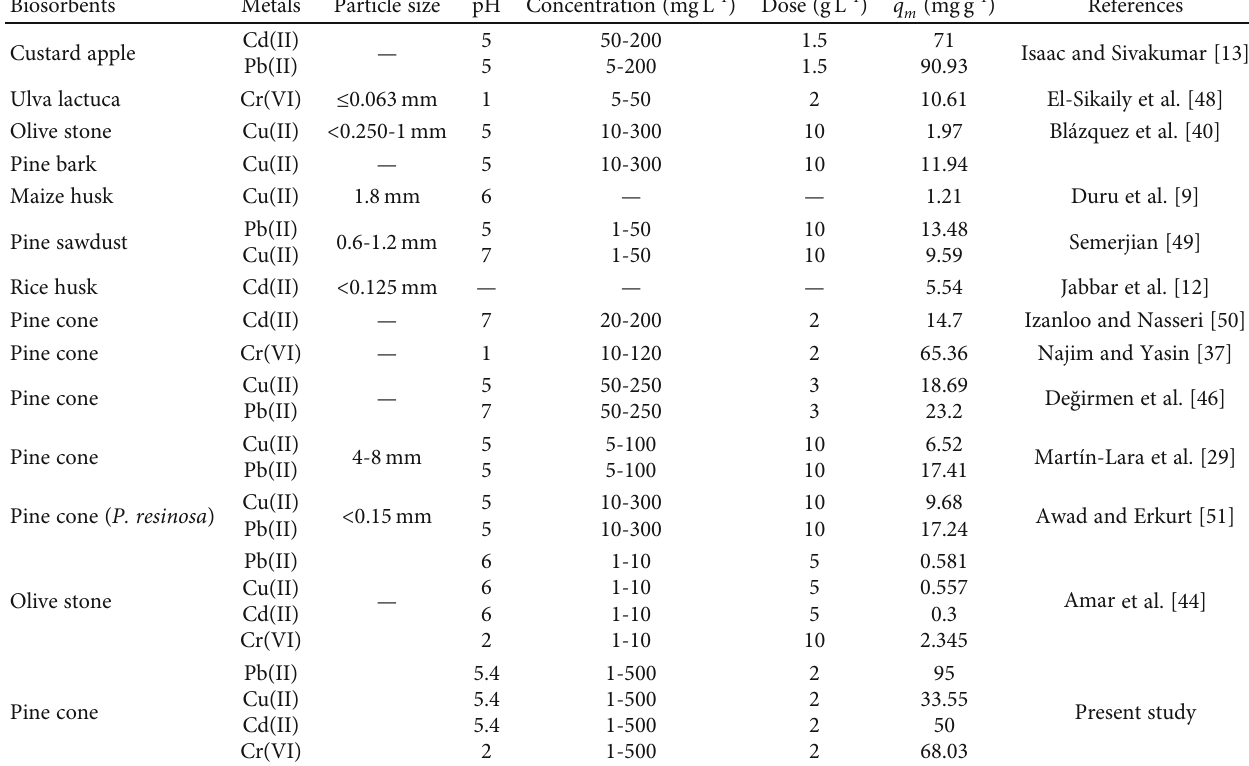
Table 2: Comparison of the adsorption capacity of milled pine cone for Pb(II), Cu(II), Cd(II), and Cr(VI) with the other biosorbents. Biosorbents